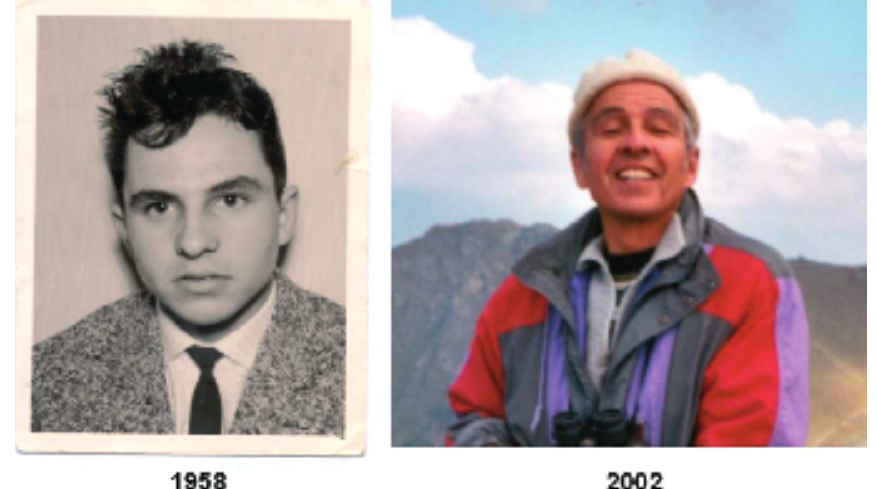
Autosomal-dominant inheritance of OPMD: the patients’ mother at his wedding day; note the marked pto- sis (circle/arrow). The photograph is published with the informed consent of the